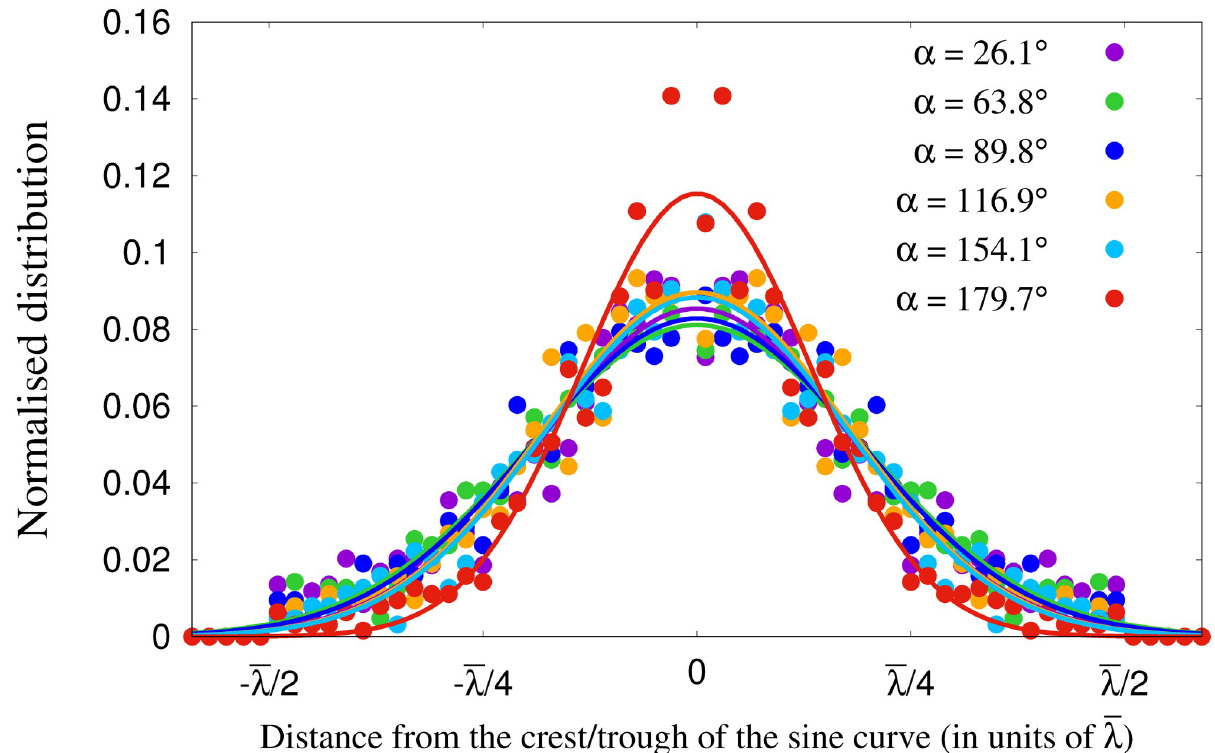
Fig 14. Accuracy of the pattern matching procedure. Figure shows Normalised distributions for the distances of pedestrian positions from the crest or troughs of the fitted 2D sinusoid i.e. the residual errors. The distributions show a Gaussian peak at the origin for each α . The data were fitted according to a Gaussian curve and the fitted curves are shown by solid